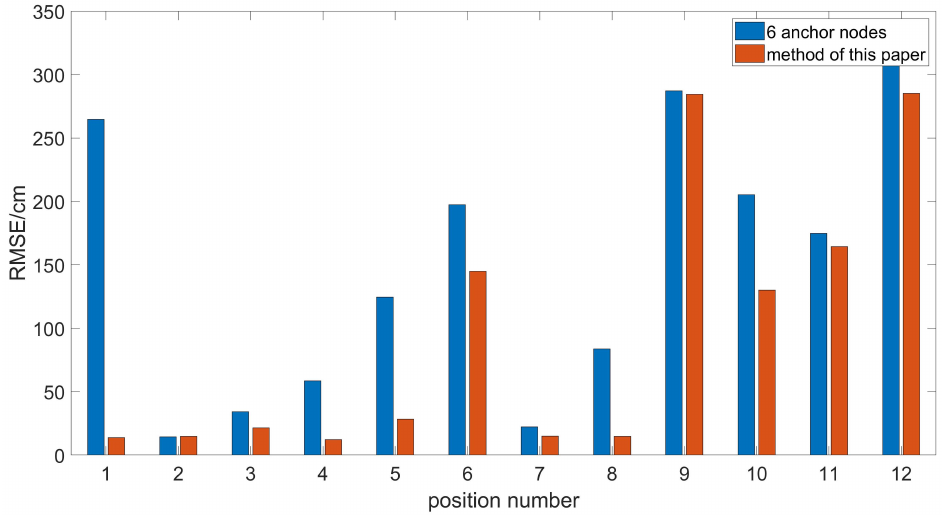
Figure 11. Result of the positioning experiments.